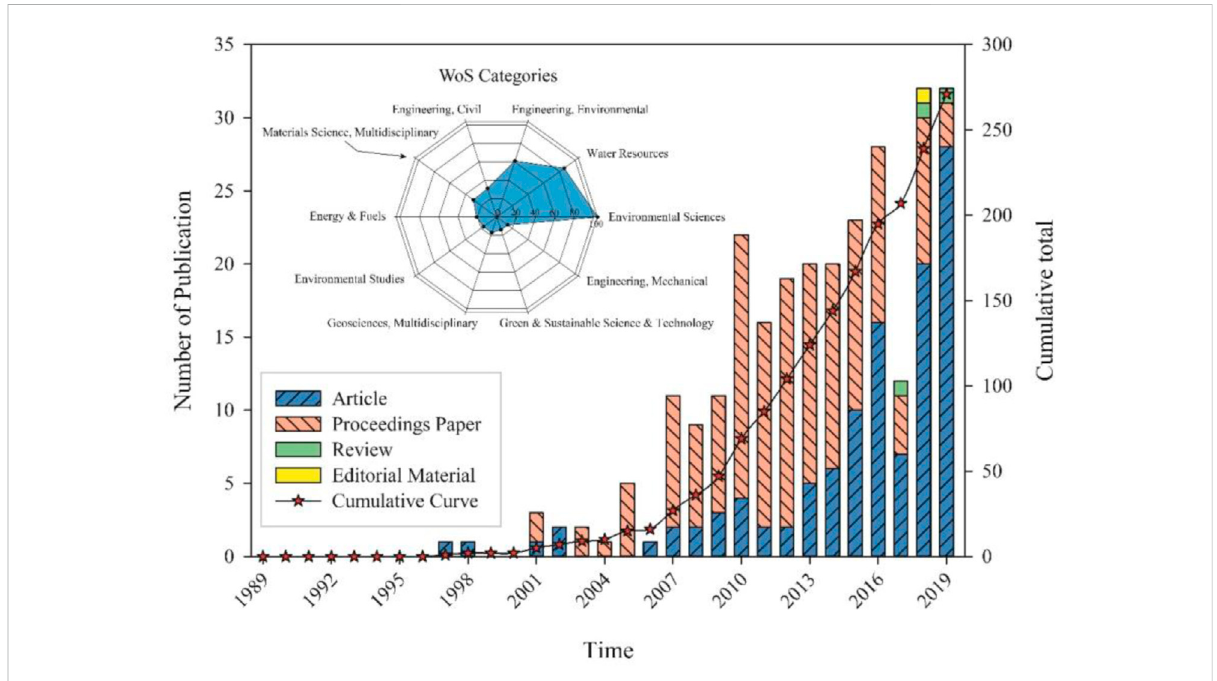
FIGURE 11 Analysis of publication on WRCC